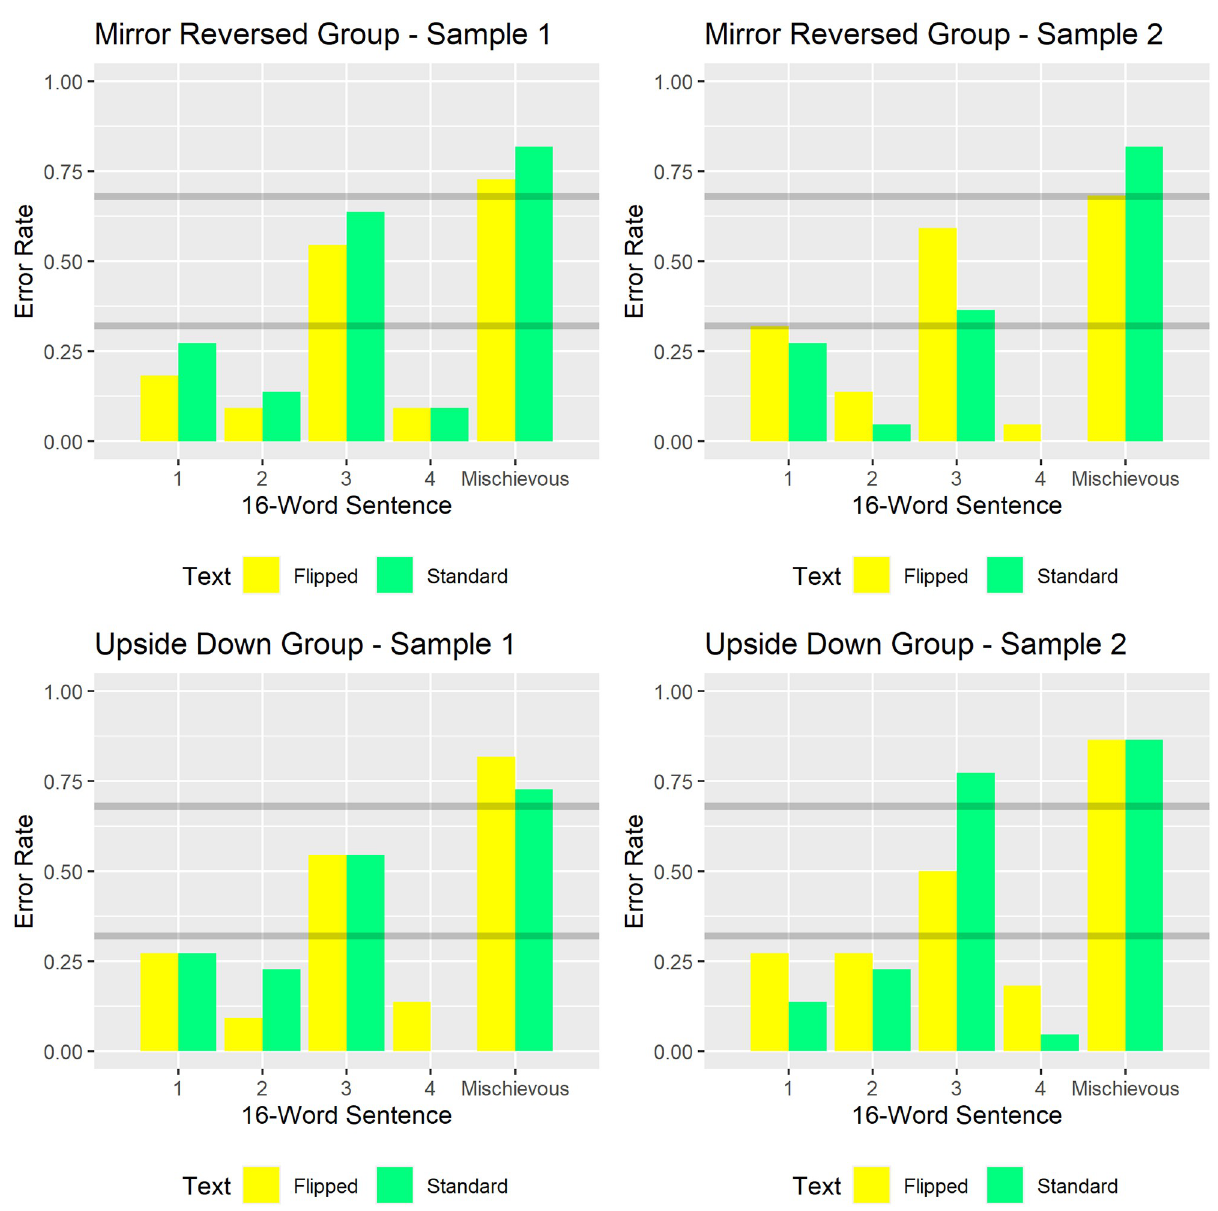
Fig 10. Sentence length heuristic and the mischievous sentence. The four panels correspond to the four groups of 22 participants. Each ordinate reflects how often participants overestimated sentence length; incorrectly judging 16-word sentences as having more than 17 words. Gray horizontal lines at 0.32 and 0.62 respectively reflect error rates significantly (p < 0.05) better and worse than pure guessing. In each group, the 3-line, 16-word “mischievous” sentence generated significantly (p < 0.05) worse-than-chance performance on flipped (yellow) and standard (green) text alike. This contrasts with consistently lower error rates for sentences 1–4, which each also contained 16-words but spanned two rather than three text lines. The specificity and reproducibility of the mischievous sentence effect suggest that participants judged sentence length by heuristically counting lines, not by explicitly counting